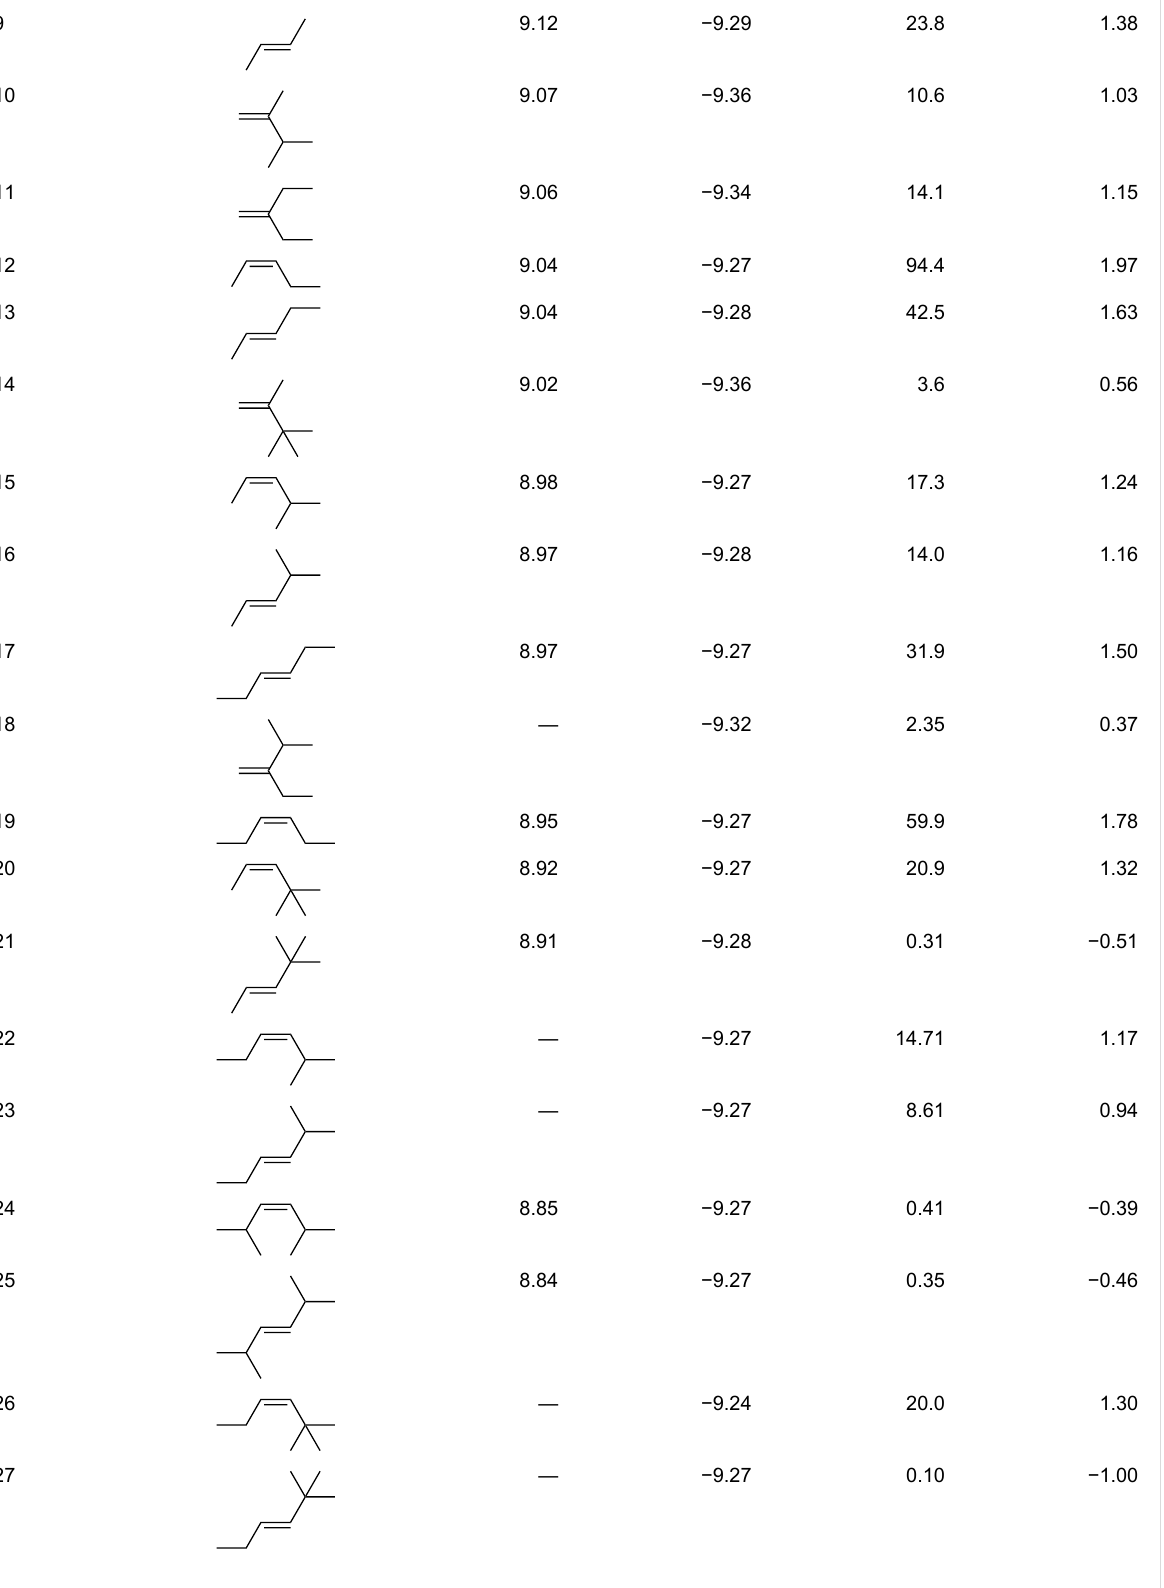
Table 1: Representative alkene IEs (eV), HOMO energies (eV), relative rates ( k rel ), and log k rel values of PhSeCl additions at 25 °C. (continued)